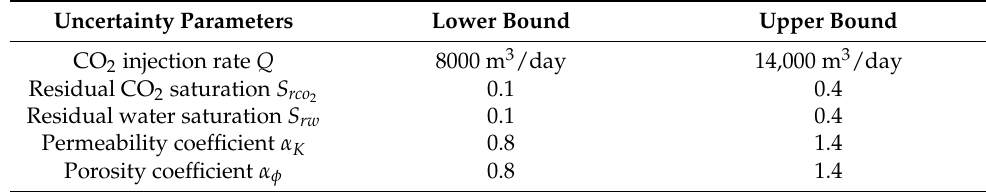
Table 2. The uncertainty parameters considered for this study with corresponding ranges.